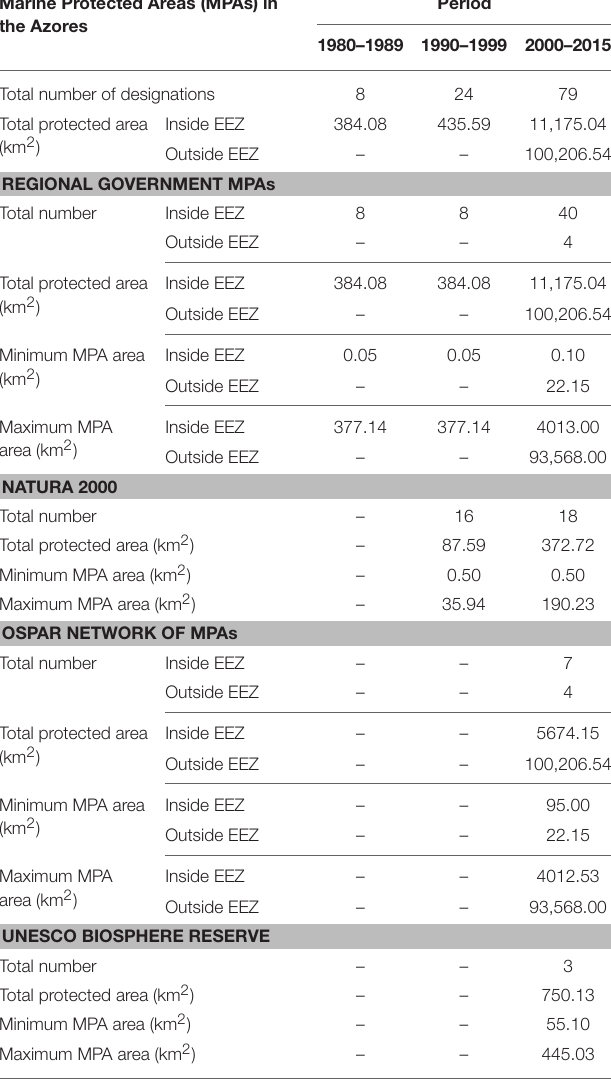
TABLE 1 | Marine protected areas (MPAs) established in the Archipelago of the Azores between 1980 and 2015, both within and beyond the Exclusive Economic Zone (EEZ), and including those MPAs legally established and driven by the Regional Government, included in NATURA 2000, and recognized by the OSPAR Commission and